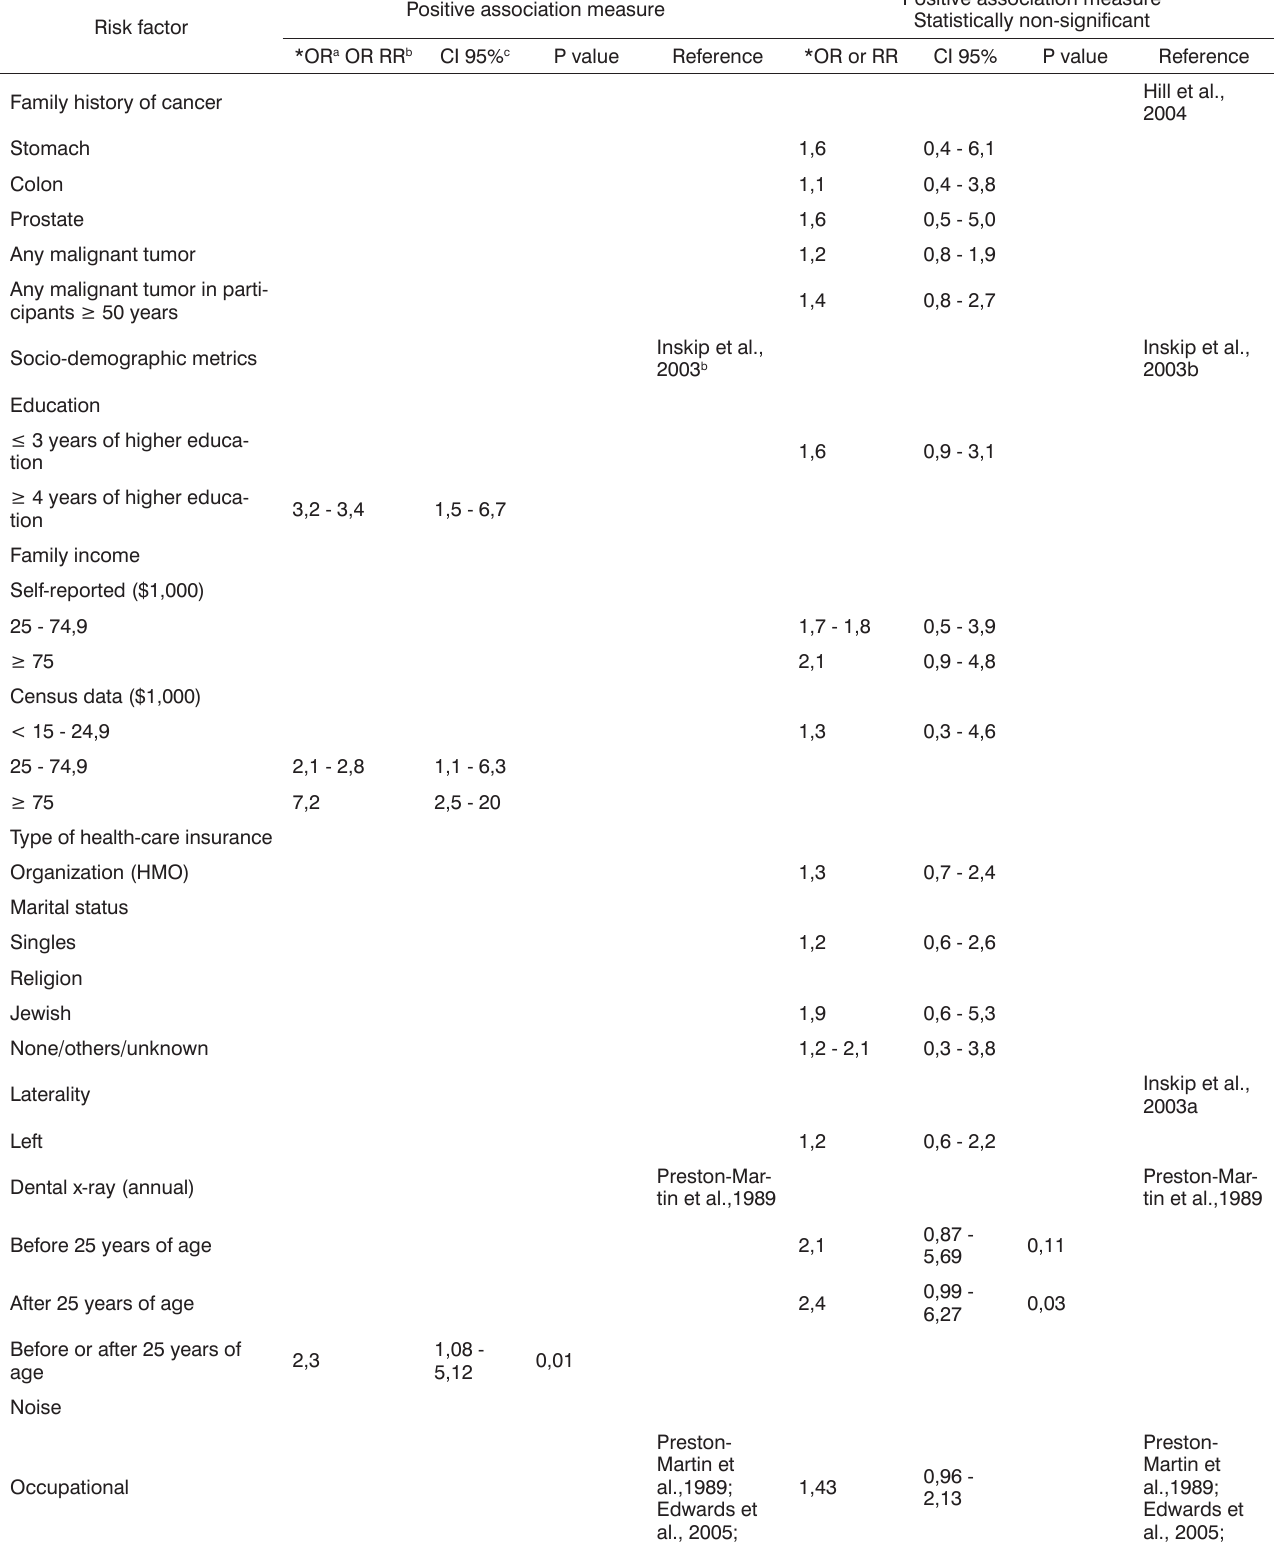
Positive association measure Statistically non-significant Hill et al., 2004